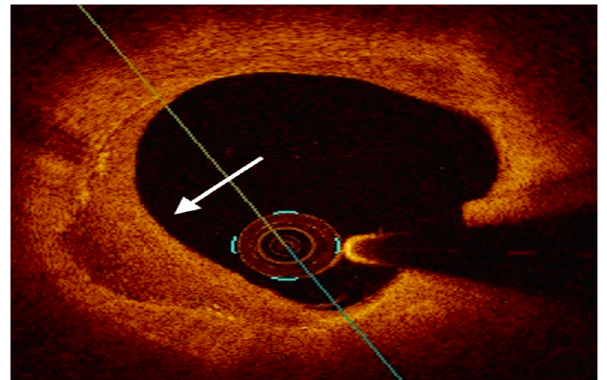
Figure 5. An example of OCT-derived healed plaque defined as a plaque presenting with one or more signal-rich layers (6 to 11 o’clock position, white arrow) of different optical density and a clear demarcation from underlying components in at least three consecutive frames along the entire plaque.